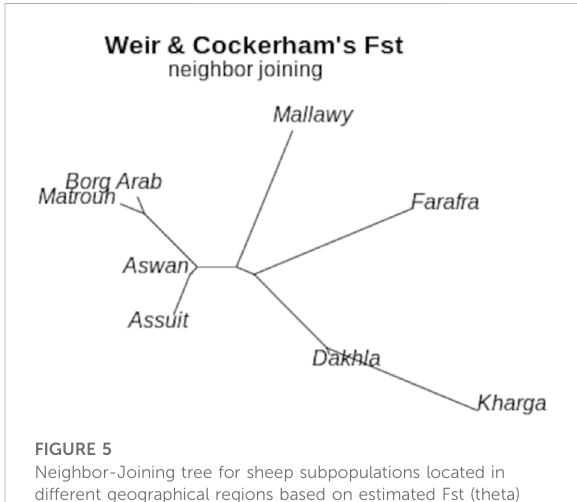
FIGURE 5 Neighbor-Joining tree for sheep subpopulations located in different geographical regions based on estimated Fst (theta) values calculated using the Weir-Cockerham fi xation index method (Weir and Cockerham,